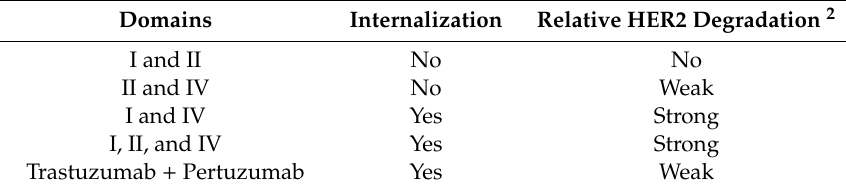
Table 4. Antibody cocktail effect on internalization and HER2 degradation from [49] 1